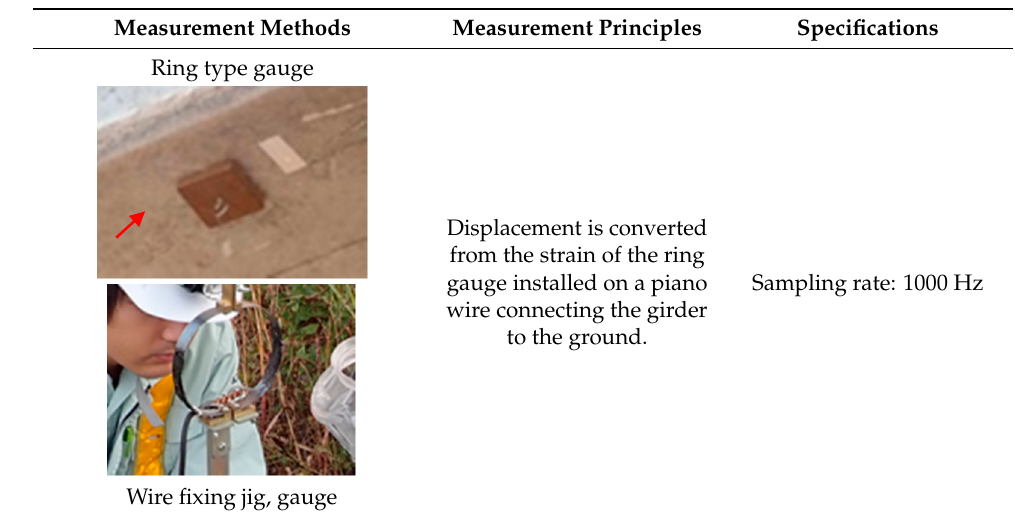
Figure 8. Installation status of each measuring device for bridge B. Table 6. Specifications of the measuring equipment on bridge B.